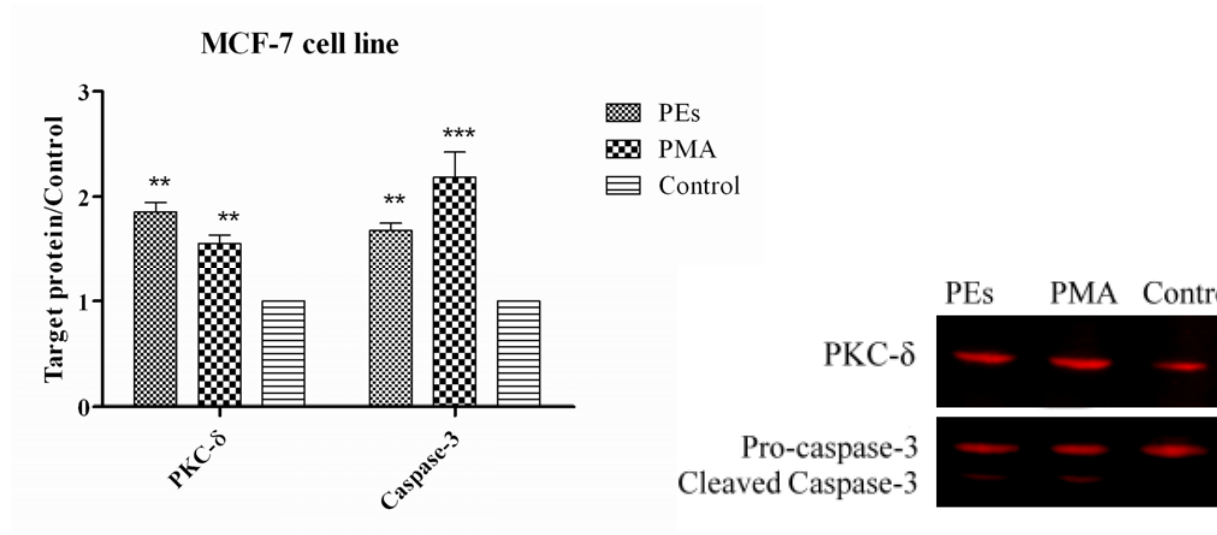
Figure 7. Expression of PKC- δ and Caspase-3 proteins in treated and un-treated MCF-7 cell line. Cells were treated with isolated PEs from Jatropha meal and PMA at the IC concentration incubated for 24 h. Equal amounts of total cellular protein of treated and un-treated cells were subjected to Western blot analyses for PKC- δ , Caspase-3 and GAPDH protein expression. All values represent mean ± standard error from three independent experiments, *** p ≤ 0.001 and ** p ≤ 0.01 indicate significant difference compared to the untreated